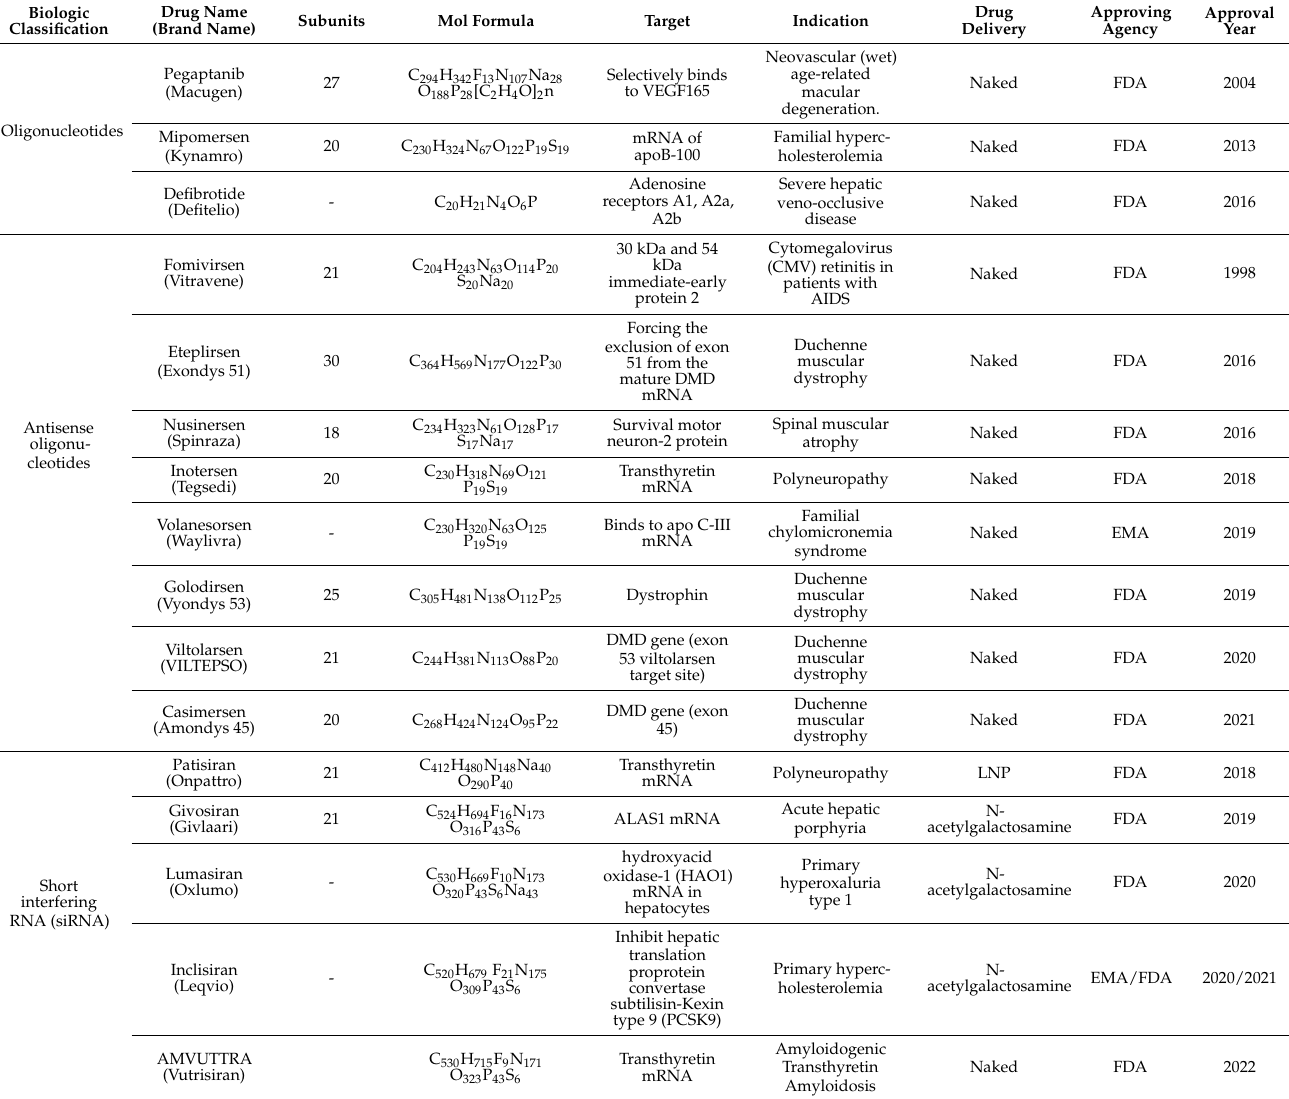
Table 1. Classification of approved nucleic acid (NA)